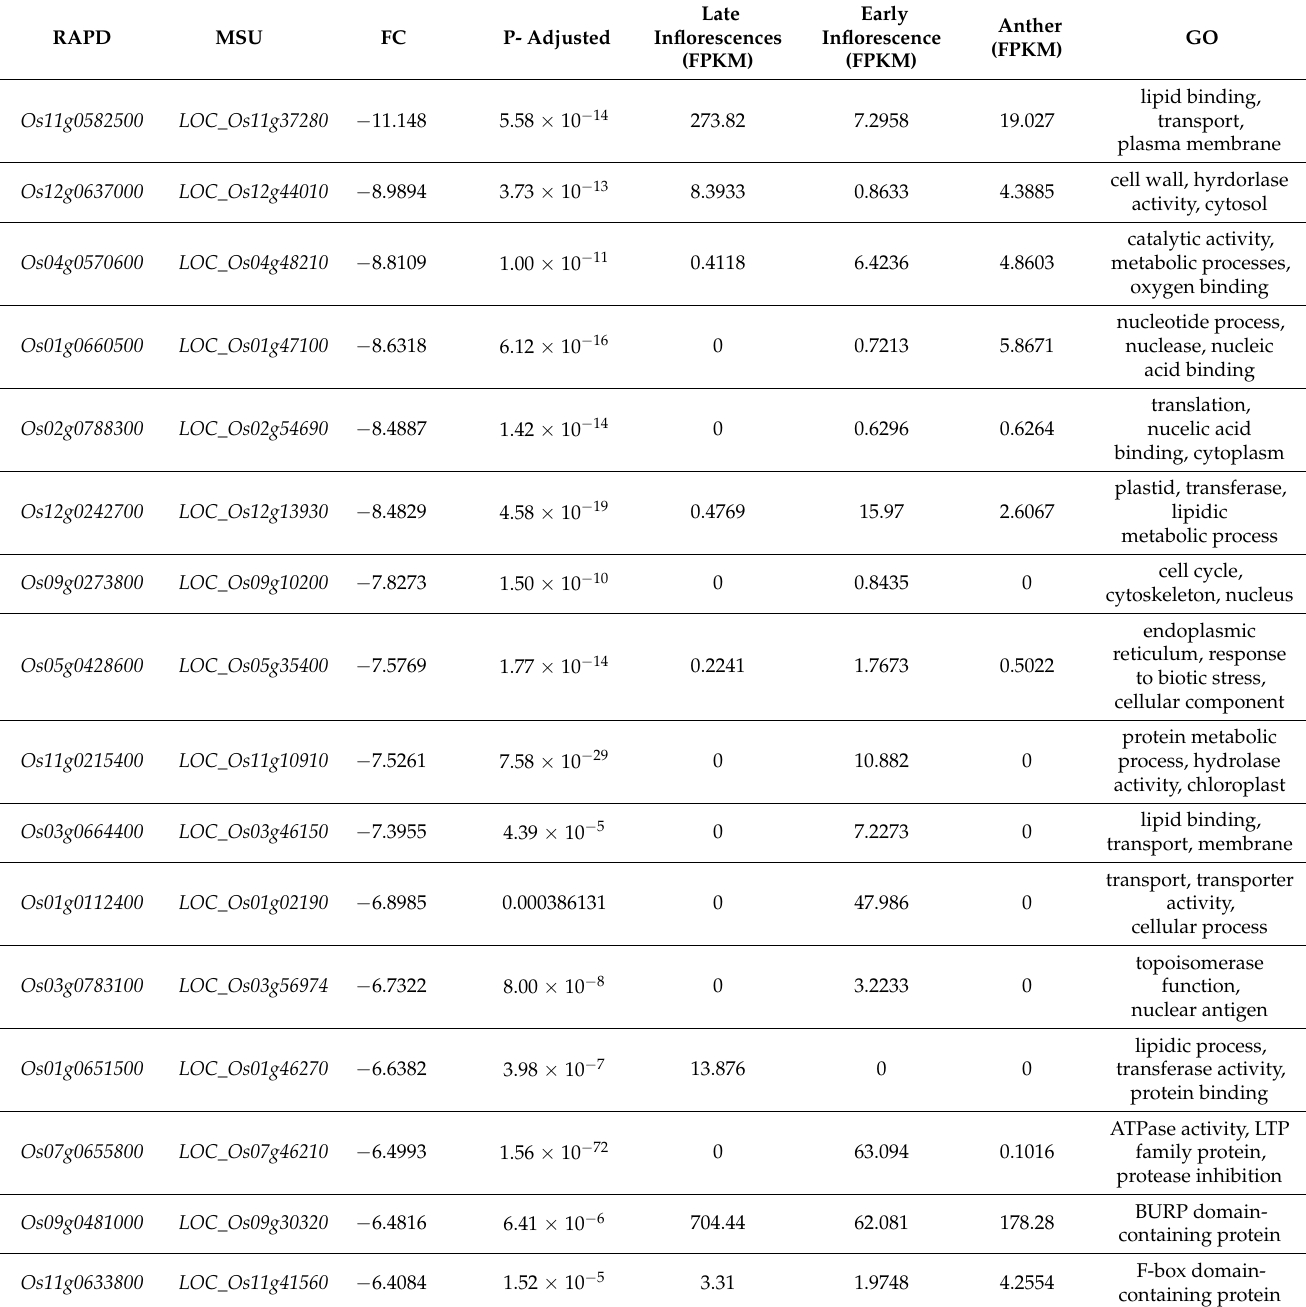
Table 1. List of downregulated DEGs, GO, and their expression spectrum in inflorescence and